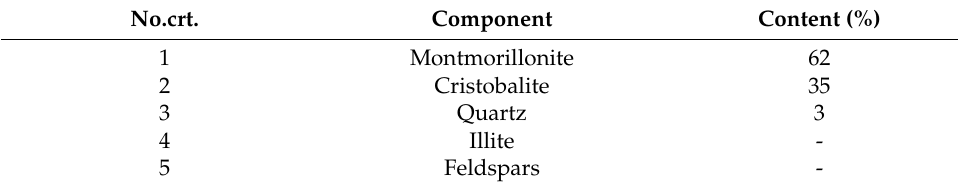
Table 1. Mineralogical composition of BN. No.crt. Component Content (%) 1 Montmorillonite 62 2 Cristobalite 35 3 Quartz 3 4 Illite - 5 Feldspars